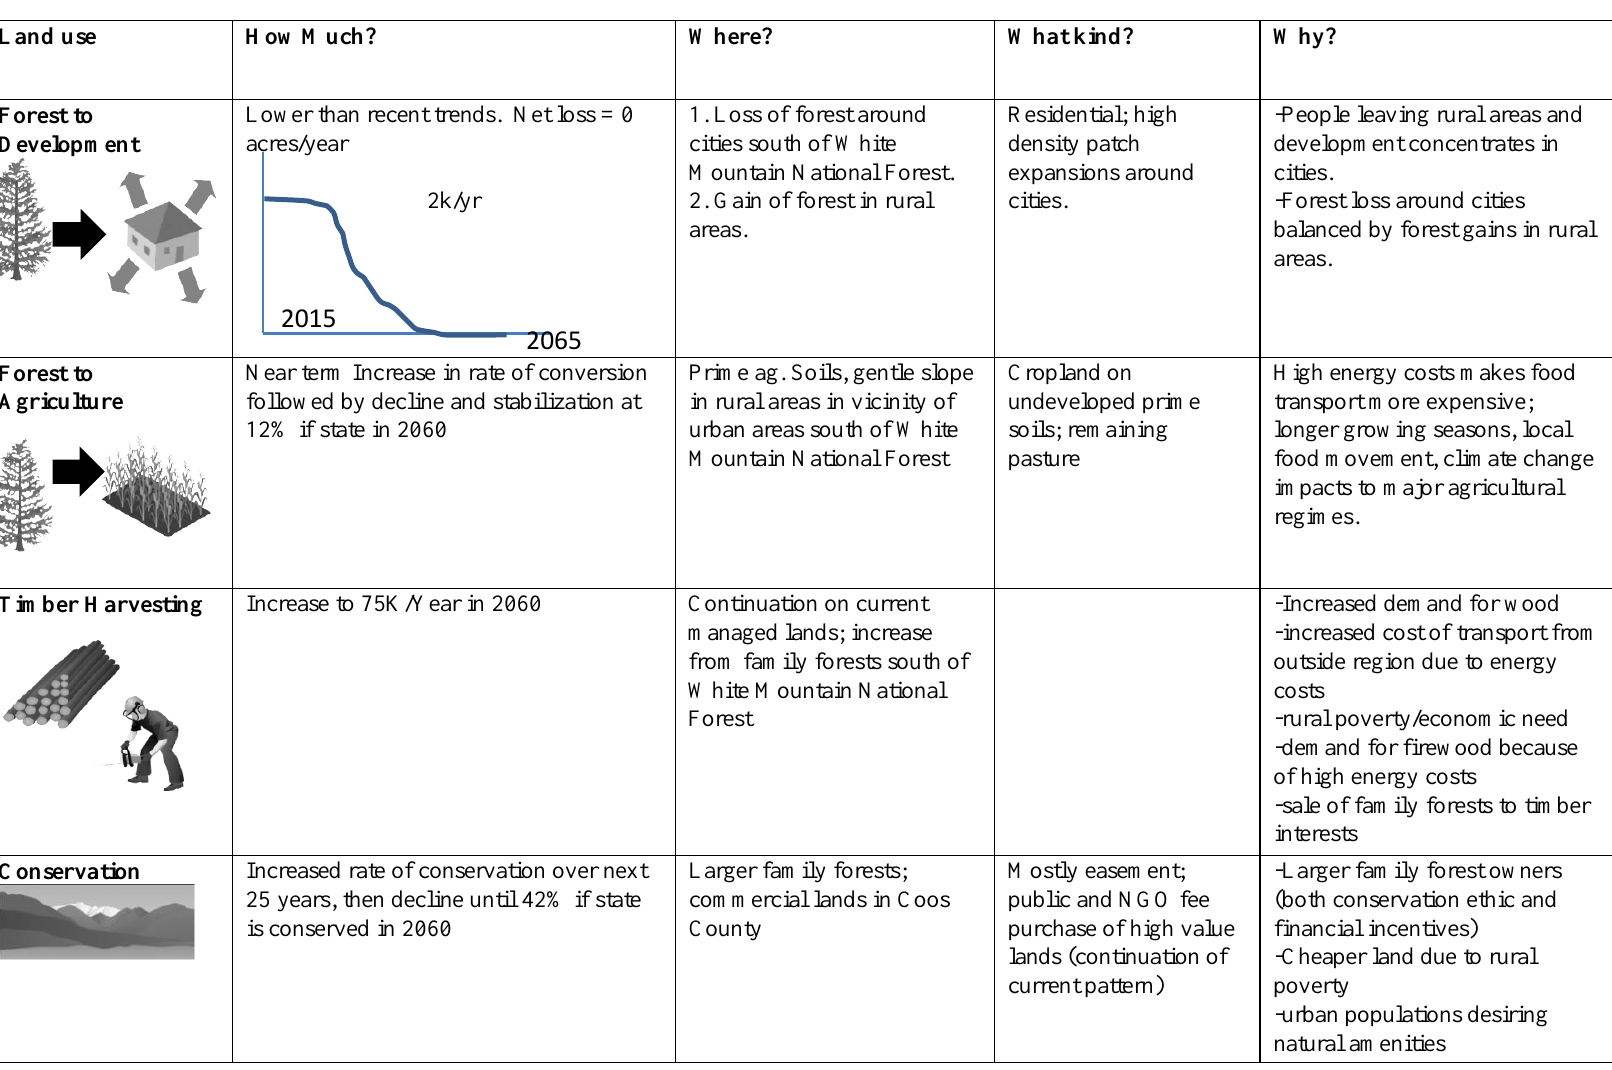
Table A2.21. Scenario 1 : Rise of the